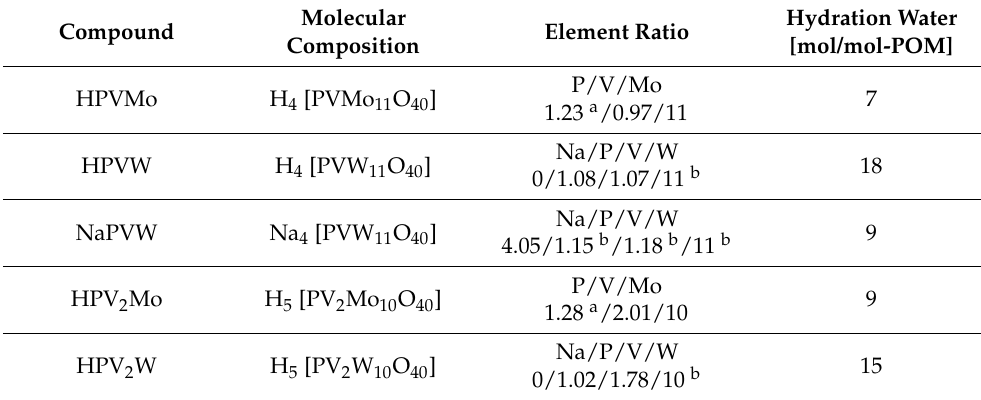
Table 1. Results from AAS/ICP-OES and TGA analyses of the different POMs analysed in this